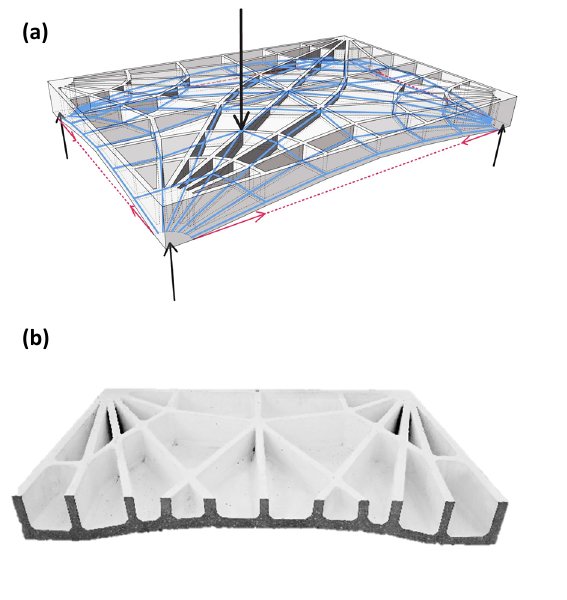
Figure 4. Funicular floors: (a) structural concept and force distribution (compression in blue, tension in red); (b) section of a funicular floor showing the rib ‐ stiffened vaulted geometry. Diagram and photo by Block Research Group.